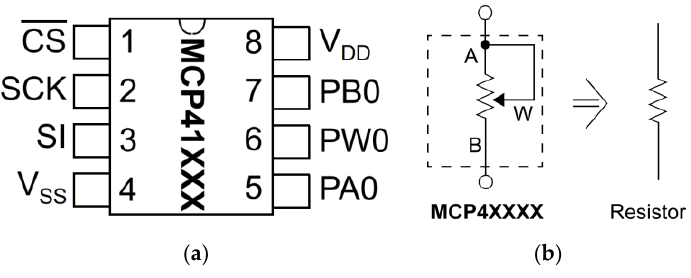
Figure 5. MCP41010 ( a ) pin configuration; ( b ) two-terminal of the rheostat mode.